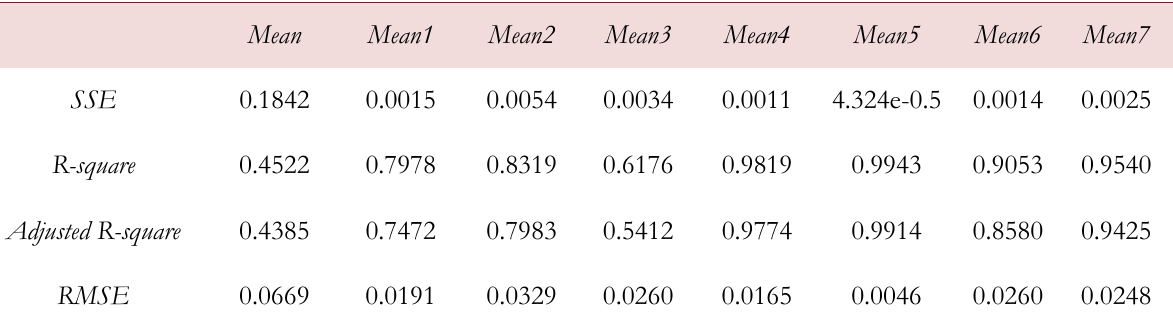
Table 7: Goodness-of-fit statistics of